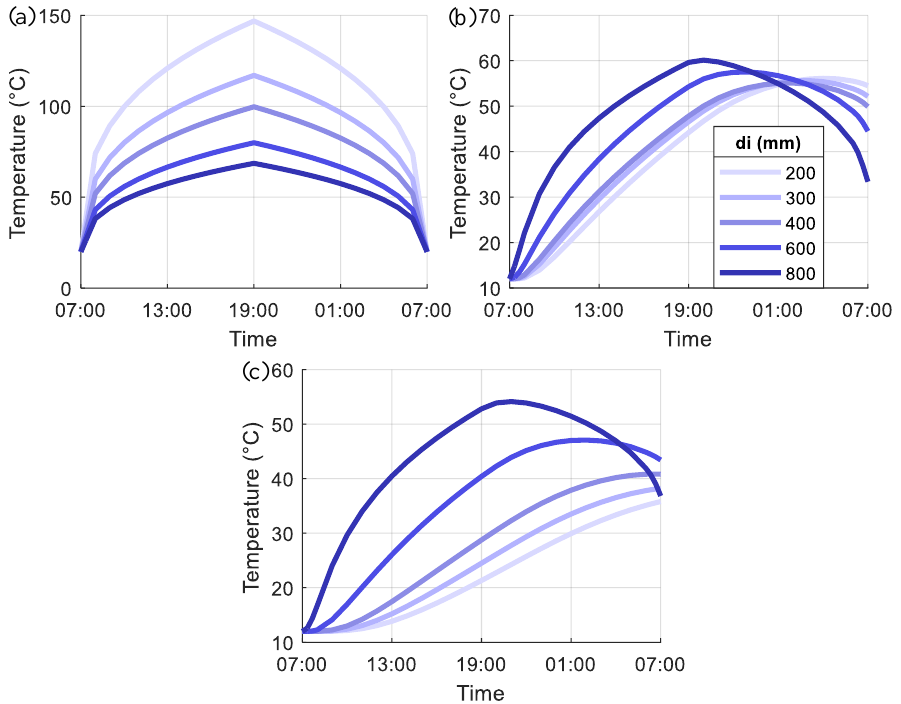
Figure 13. Temperature change in the first loading cycle for different d i at: ( a ) the inner surface of the pile section; ( b ) the midpoint of the pile section; ( c ) the outer surface of the pile section.